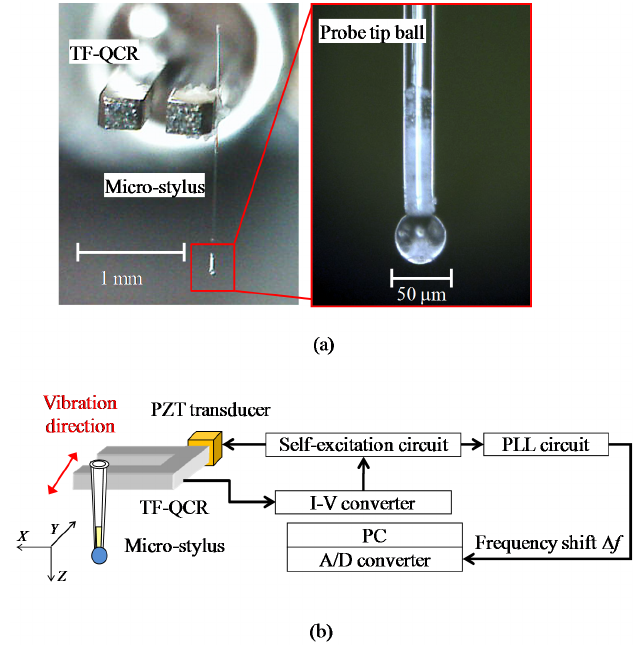
Figure 1. Configuration of shear ‐ mode micro ‐ probe. ( a ) Photograph of shear ‐ mode micro ‐ probe; ( b ) Schematic diagram of shear ‐ mode micro ‐ probe.